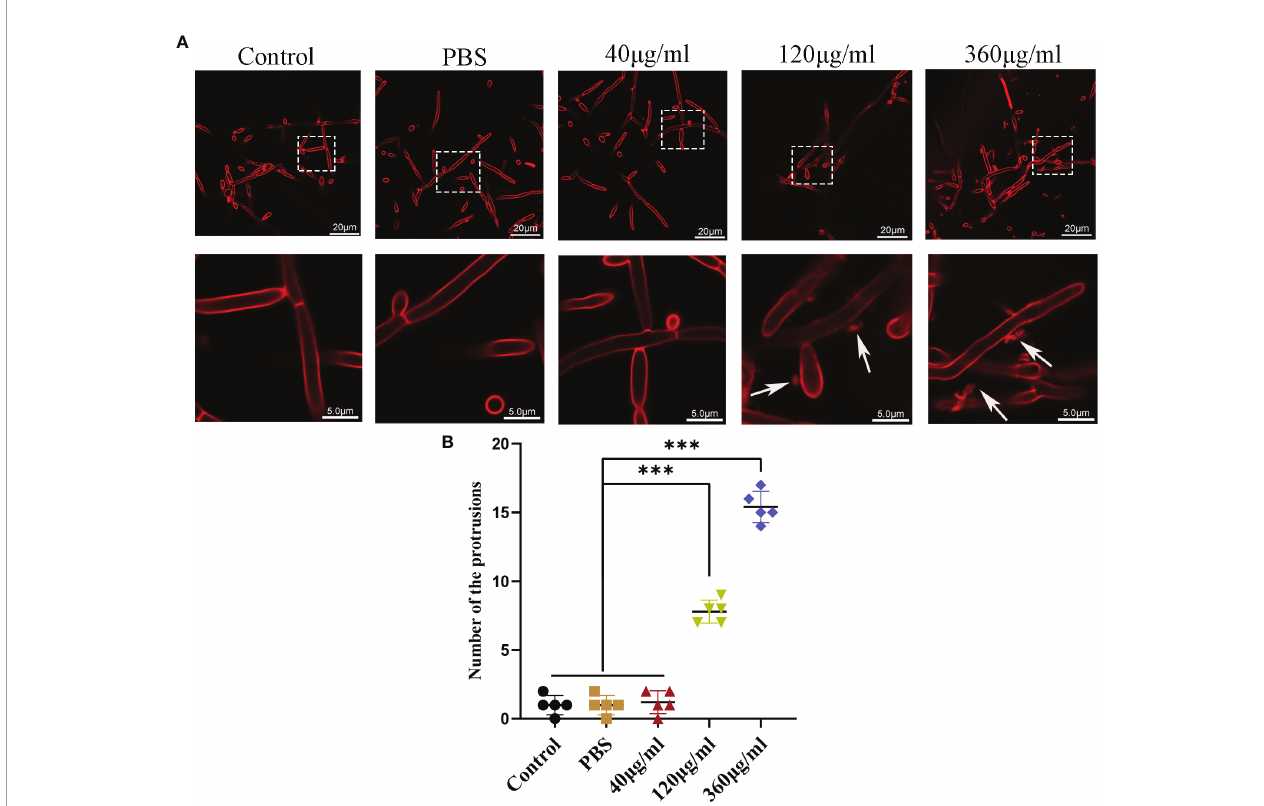
FIGURE 3 | Confocal analysis of C. albicans . (A) Representative confocal images after incubation of C. albicans with different concentrations of EVs for 12h. In both panels, the upper row shows overview images, and the bottom row shows magni fi ed images. There are some protrusions appearing on hyphae (white arrows). The scale bar of the upper row represents 20 m m. The scale bar of the bottom row represents 5.0 m m. (B) Changes in the protrusions appeared on hyphae of different groups at 12 h. There were more protrusions on hyphae in the high concentration treatment groups than in the low concentration treatment group and control group. Statistical signi fi cance was tested by one-factor ANOVA. ***P <